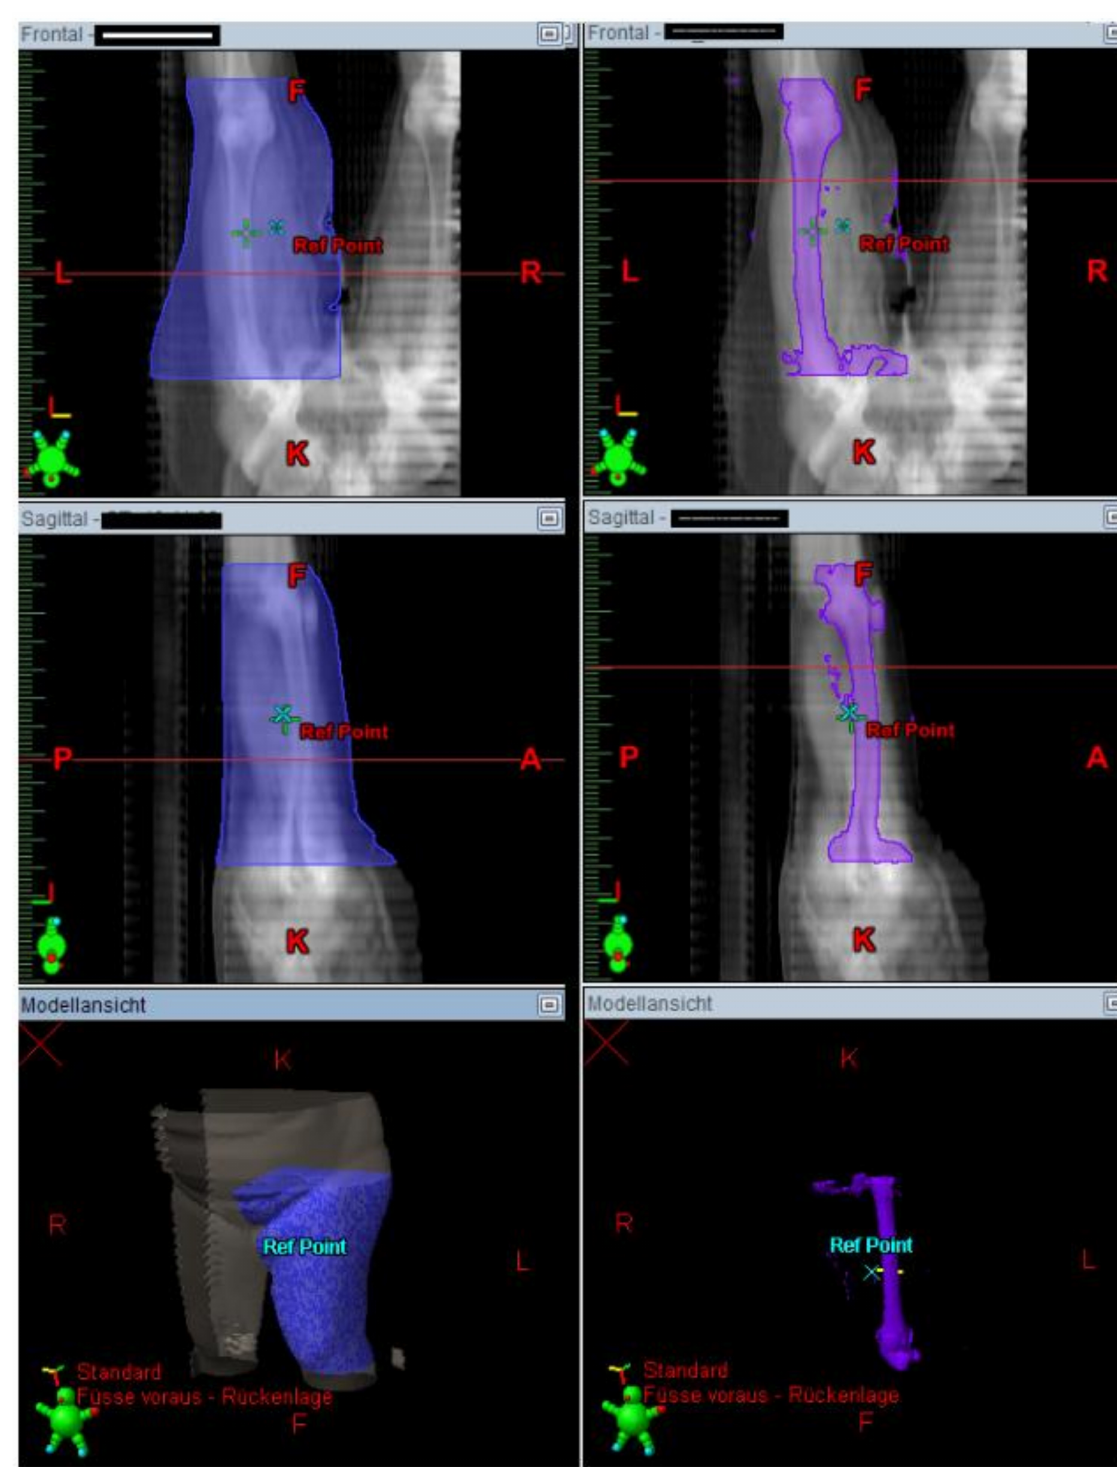
Figure 3. 3D contouring of the extremity and bone to prepare bone subtraction from the extremity